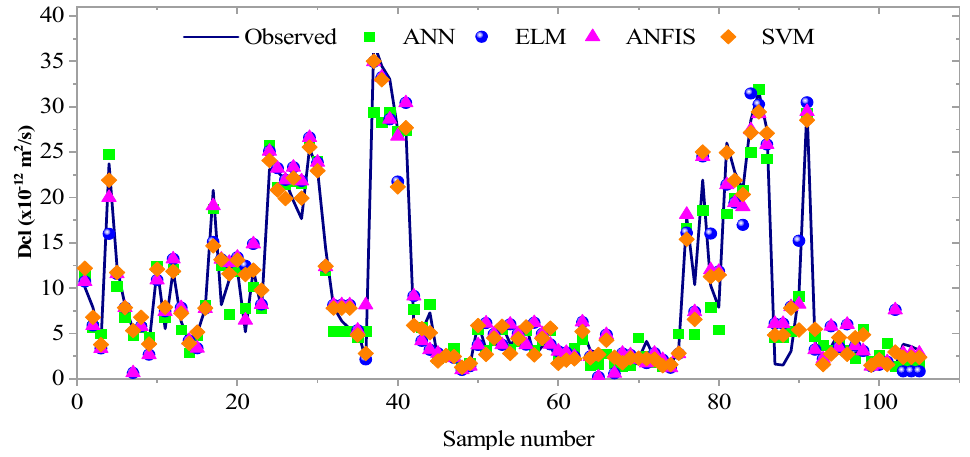
Figure 10. Predicted vs. measured plots of ML models in the testing phase.